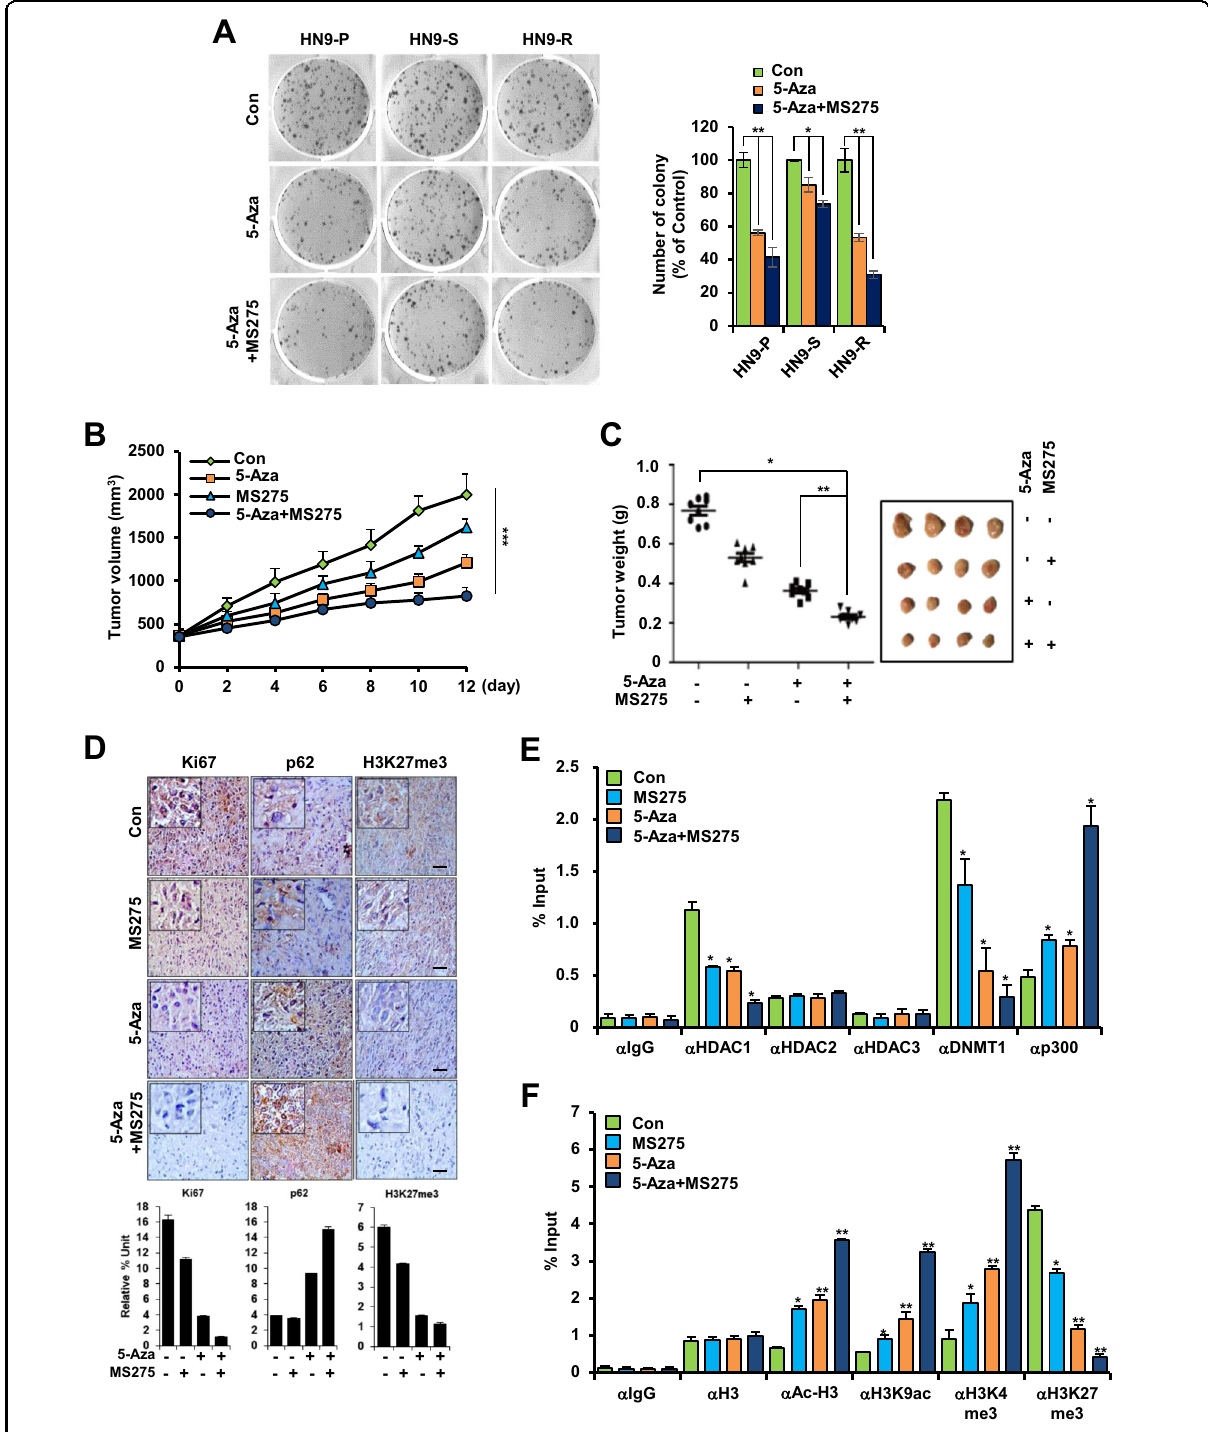
Fig. 5 Combined inhibition of DNA methylation and histone deacetylation decreases proliferative capacity and tumorigenesis of HN9-R clones. A Colony formation analysis of 5-Aza-treated HN9 cells with or without MS275. B , C In vivo tumorigenesis of HN9-R clones ( B ) and tumor weight and size of HN9-R xenograft tumors ( C ) after treatment with 5-Aza and/or MS275. D Immunohistochemistry and the quantitative analysis of Ki67, p62, and H3K27me3 expression in response to treatment with 5-Aza and/or MS275. Scale bars, 50 μ m. E , F ChIP analysis of the p62 promoter performed with antibodies against HDACs, DNMT1, p300, and H3 histone modi fi cation in HN9-R xenograft tumor tissues treated with 5-Aza and/or MS275. Values are means ± standard deviation (SD) for eight mice ( B – F ). * p < 0.05; ** p < 0.01; *** p <